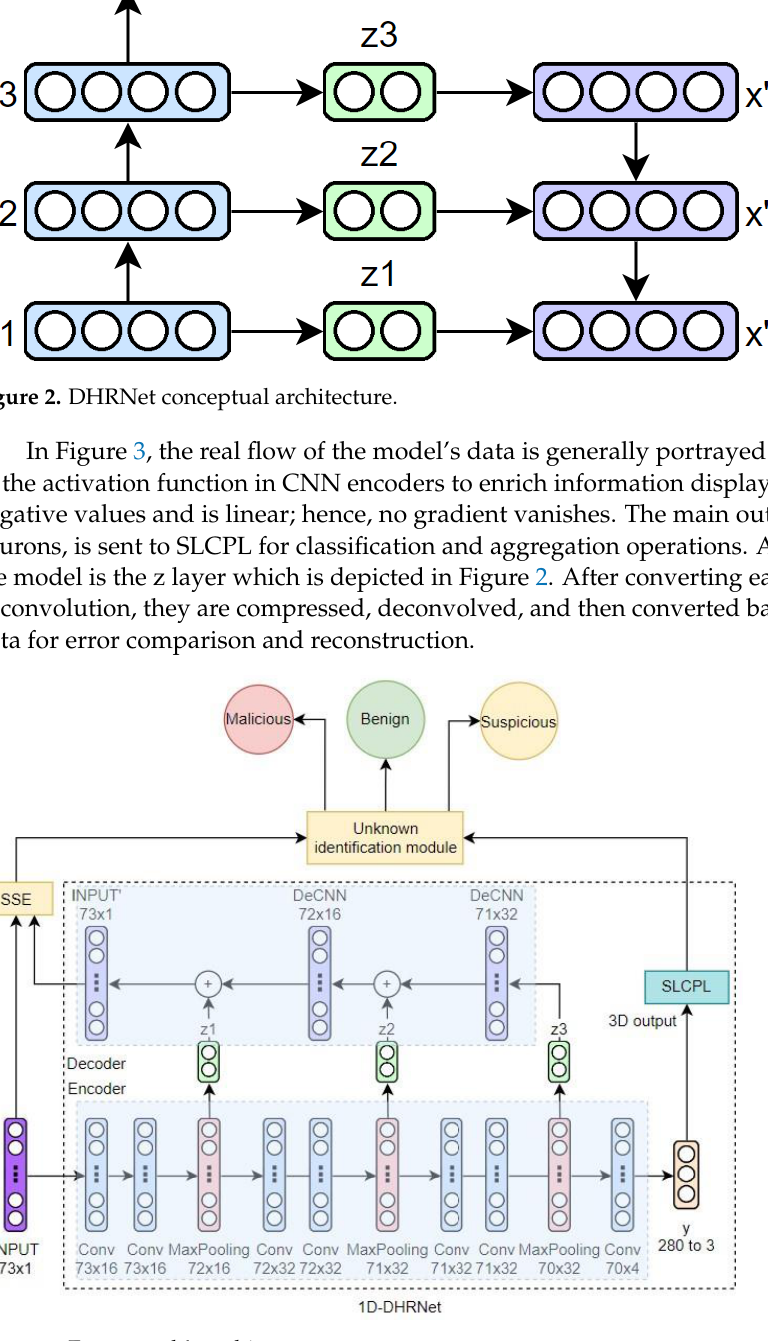
Figure 3. Framework ’ s architecture . Figure 3. Framework’s